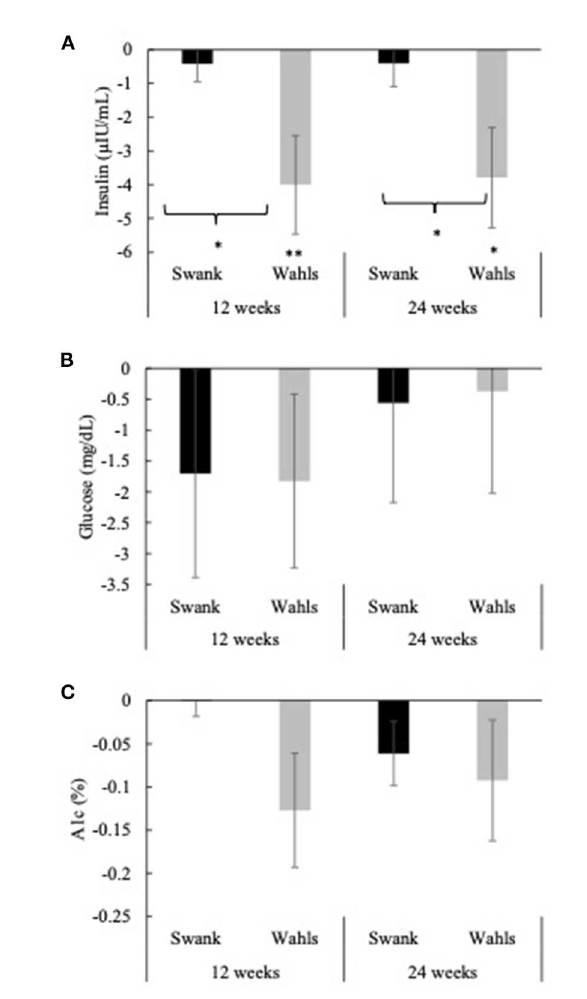
FIGURE4 Mean change from baseline for (A) insulin, (B) glucose, and (C) hemoglobin A1c at 12- and 24-weeks for the Swank (black bars) and Wahls (gray bars) groups. Statistical significance was determined by generalized linear mixed models and represented by * p ≤ 0.05 and ** p ≤ 0.01.